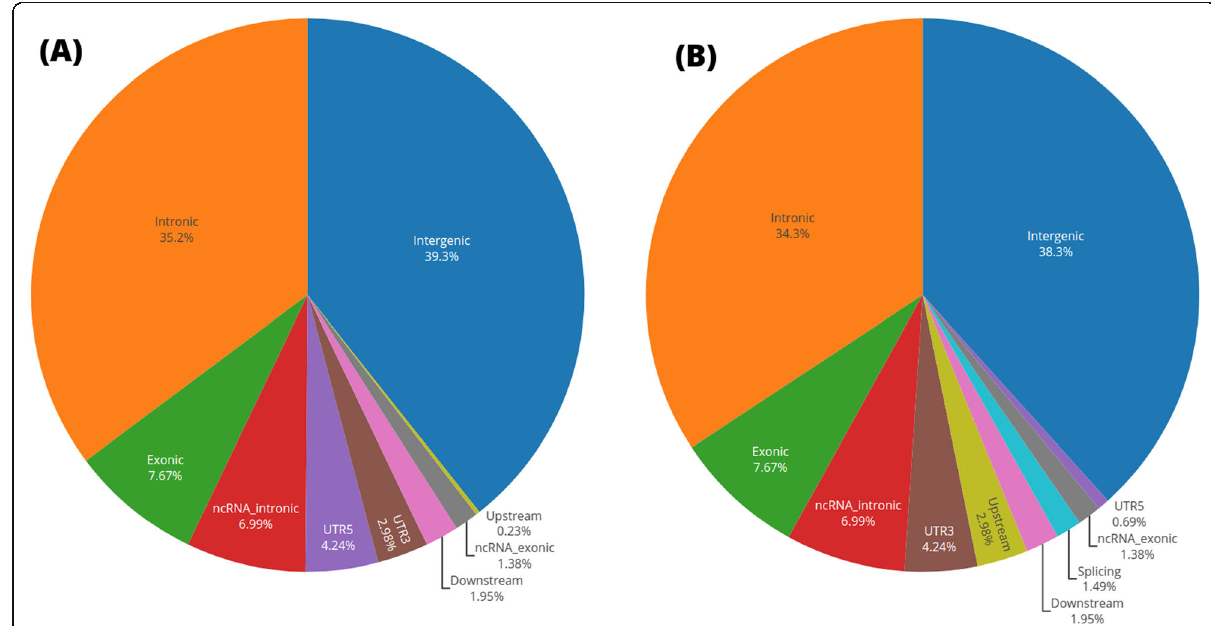
Fig. 2 Characterization of SCD gene function and exome map from the targeted next generation sequencing: This included the exon and full regions for validated and novel fetal hemoglobin-associated loci, including B-cell lymphoma/leukemia 11A ( BCL11A ), proto-oncogene, transcription factor ( MYB ), Homeobox A9 ( HOXA9 ), Hemoglobin subunit beta ( HBB), hemoglobin subunit gamma 1 ( HBG1 ), hemoglobin subunit gamma 2 ( HBG2 ), chromodomain helicase DNA binding protein 4 ( CHD4 ), Kruppel like factor 1 ( KLF1 ), methyl-CpG binding domain protein 3 ( MBD3 ), zinc finger and BTB domain containing 7A ( ZBTB7A ), Peptidoglycan recognition protein 1 ( PGLYRP1 ) on chromosomes 2, 6, 7, 11, 12 and 19, respectively. a gene functions from patients with high HbF levels and b gene functions from patients with low HbF